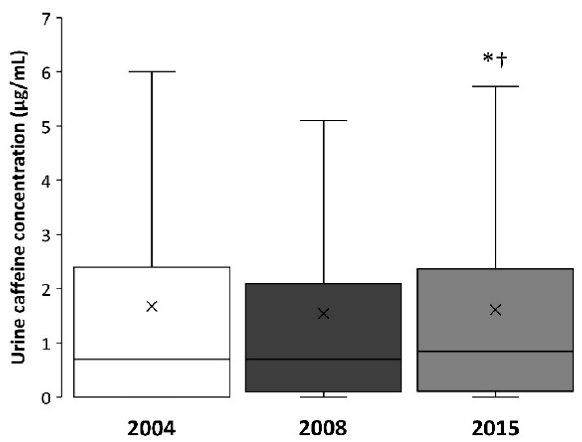
Figure 1. Box-and-whisker plot for caffeine concentration in the urine samples of Olympic sports collected in 2004, 2008, and 2015. The cross depicts the mean value while the lower, middle and upper lines of the box represent the 25%, 50% and 75% percentile. Whiskers represent 1.5 × interquartile range. Outlier data have been removed to facilitate the comprehension of the figure. (*) Different from 2004 at p < 0.05; (†) Different from 2008 at p < 0.05.